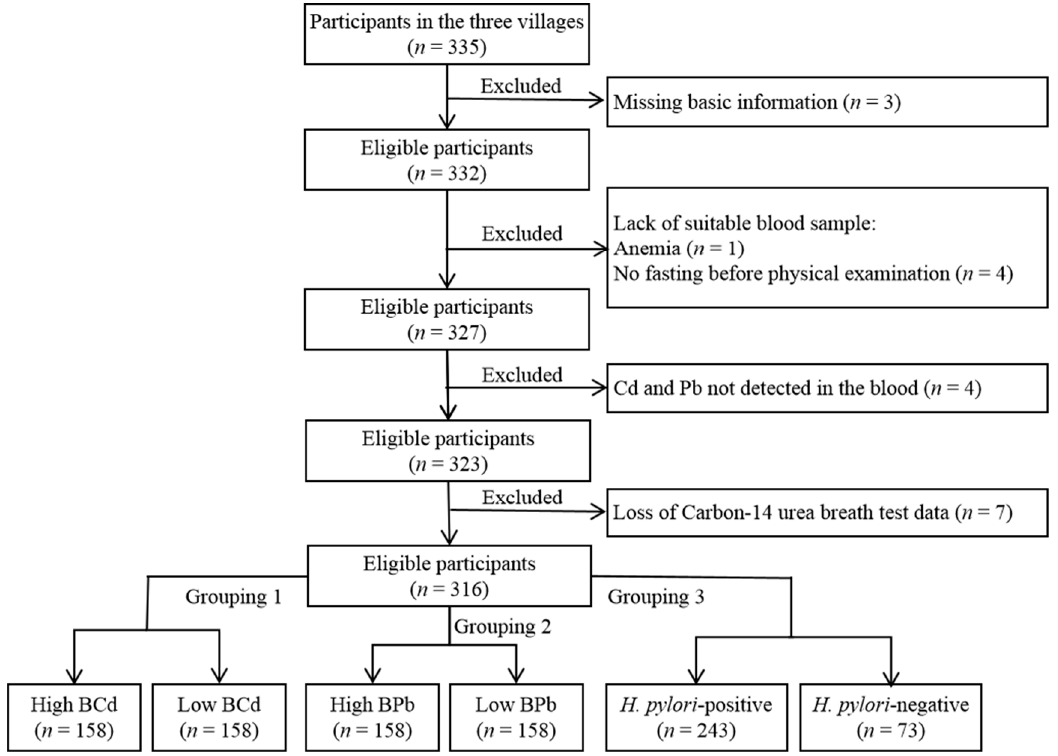
Figure 2. Flow chart of study participants who met the inclusion criteria and were included in this study ( n = 316). Blood cadmium (BCd) and blood lead (BPb) levels were recoded into categorical variables classified as high ( ≥ 50th percentile), or low (<50th percentile).